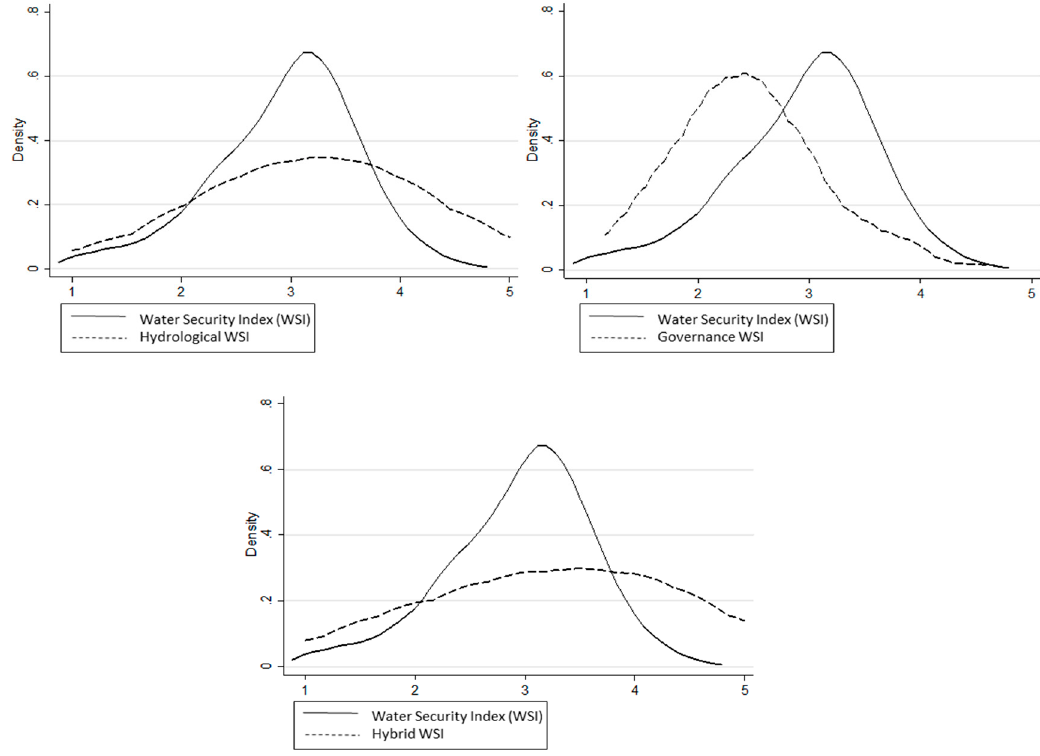
Figure 3. Distribution (k-density plots) of the three dimensions of irrigation water security. Source: Survey data 2013; Note: Scale from 1 = insecure to 5 = secure.